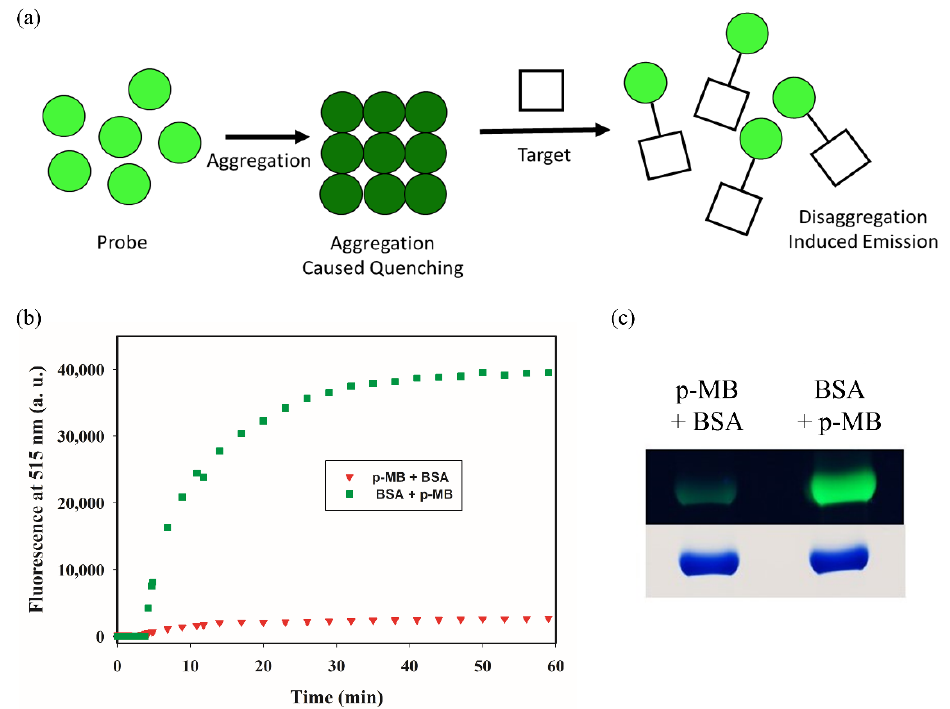
Figure 7. Effect of aggregation on p-MB’s reactivity. ( a ) General mechanism of DIE. ( b ) Kinetics of reaction between p-MB (50 µM) and BSA (50 µM) in PBS containing 5% DMSO ( v / v ). Red plot corresponds to BSA added after preincubation of p-MB in reaction buffer. Green plot corresponds to p-MB added from a stock in DMSO to the reaction buffer containing BSA. The excitation wavelength was 470 nm. ( c ) SDS-PAGE analysis of the same samples from ( b ). Top corresponds to in-gel fluorescence imaged under long-wavelength UV light, while bottom corresponds to the same gel imaged under white light after Coomassie Blue staining. Full gel images are shown in Supplementary Figure S8.